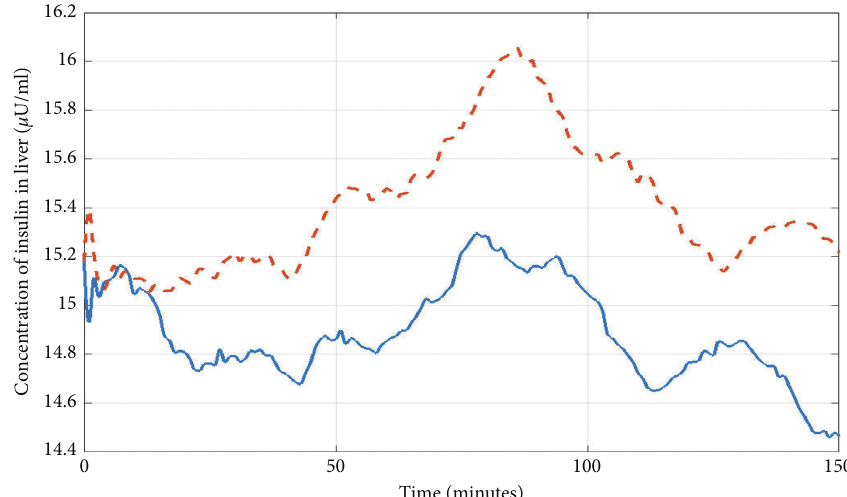
Figure 9: Hepatic insulin profile during euglycemic hyperinsulinemic clamp test. The dashed line shows the type 2 diabetic patients hyperglycemic clamp test, while the solid line shows the same for healthy subjects.